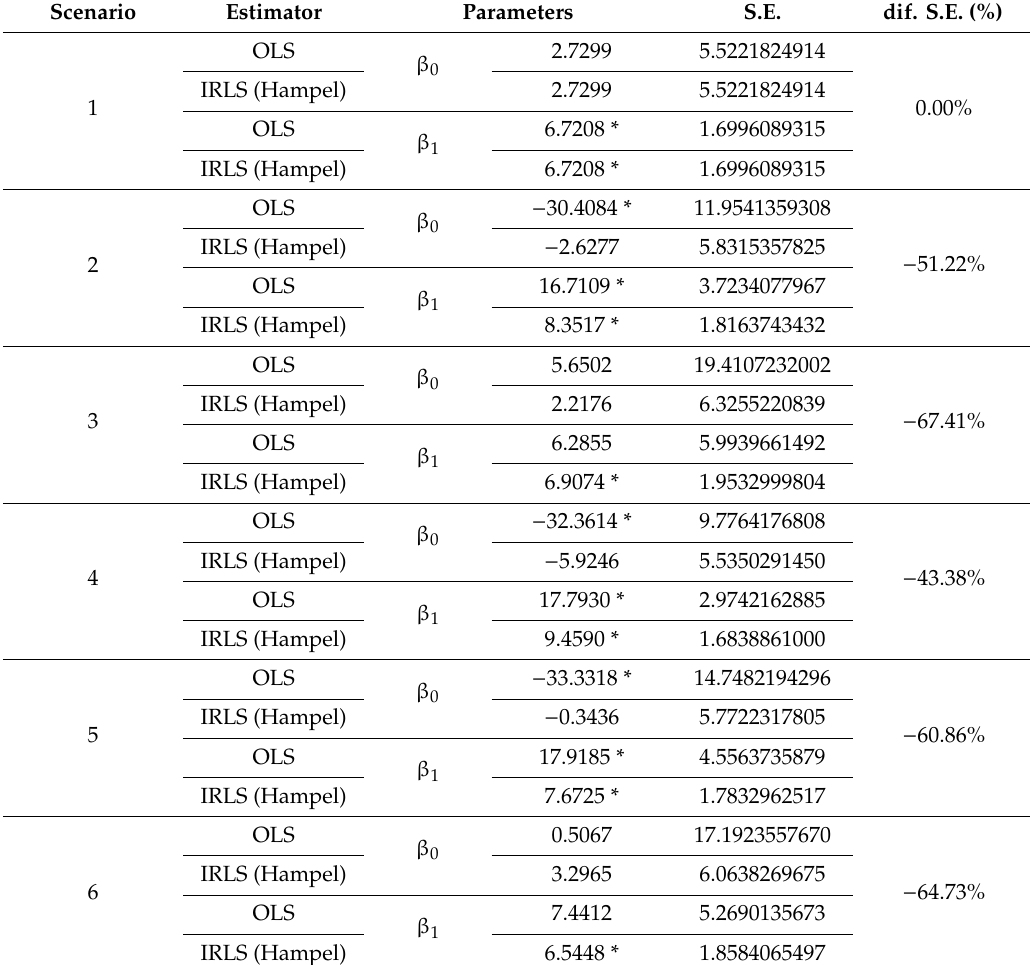
Table9. ParametersstandarderrorsintheHenriksen’smodelfittedtopredicttotalheightof O.pyramidale from a subsample of data with 4.7-year-old trees in Ecuador (Approach